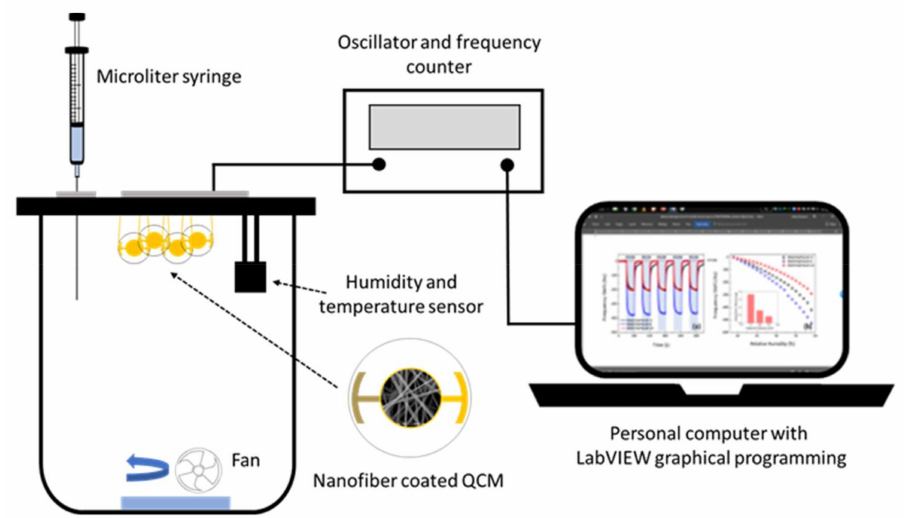
Figure 2. Schematic illustration of safrole QCM gas sensing